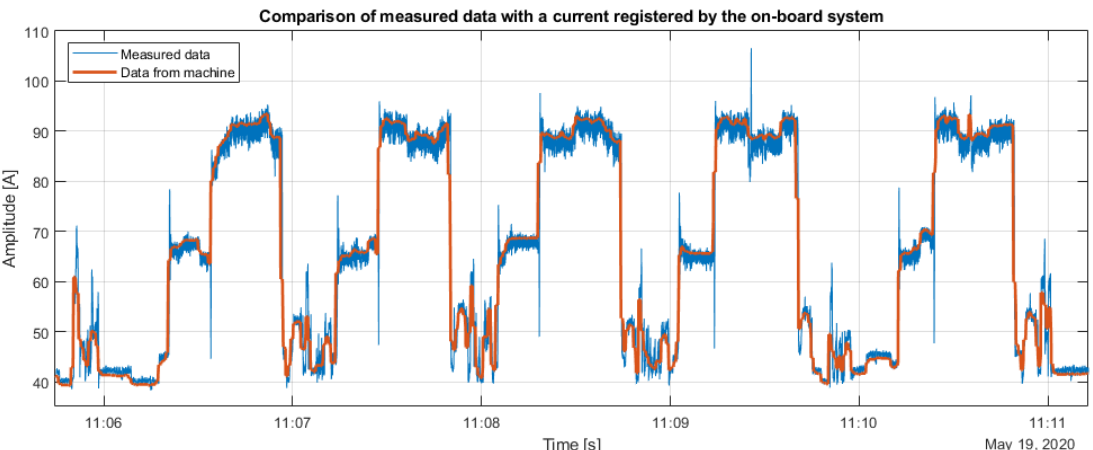
Figure 16. Comparison of the shape and scale of the measured signal (blue) to that registered by the machine system